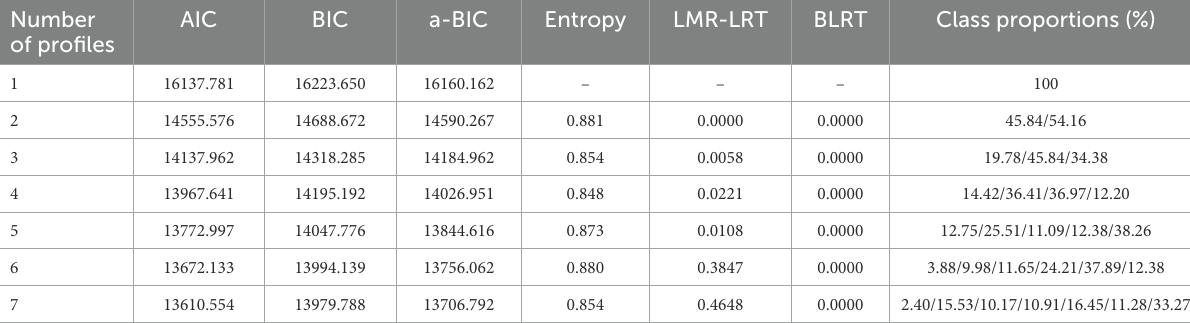
TABLE 3 Fit statistics for Class Models 1 through